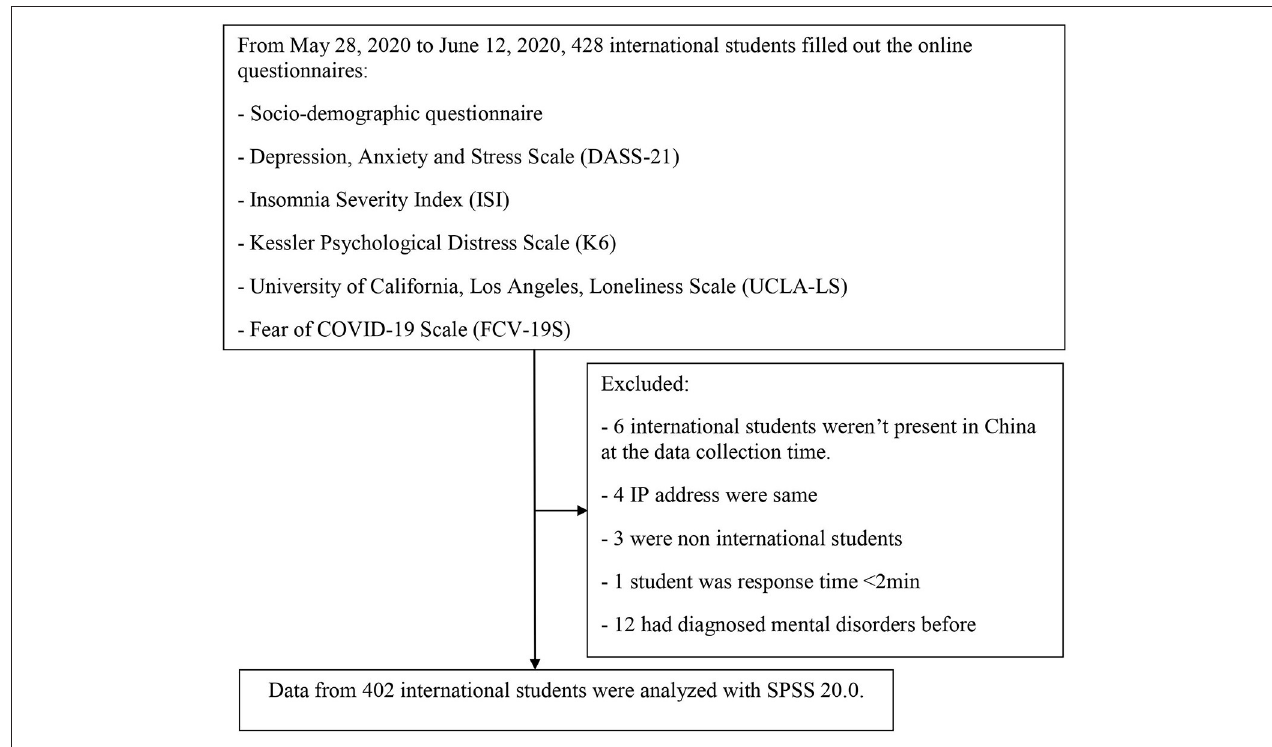
FIGURE 1 | Flowchart of the